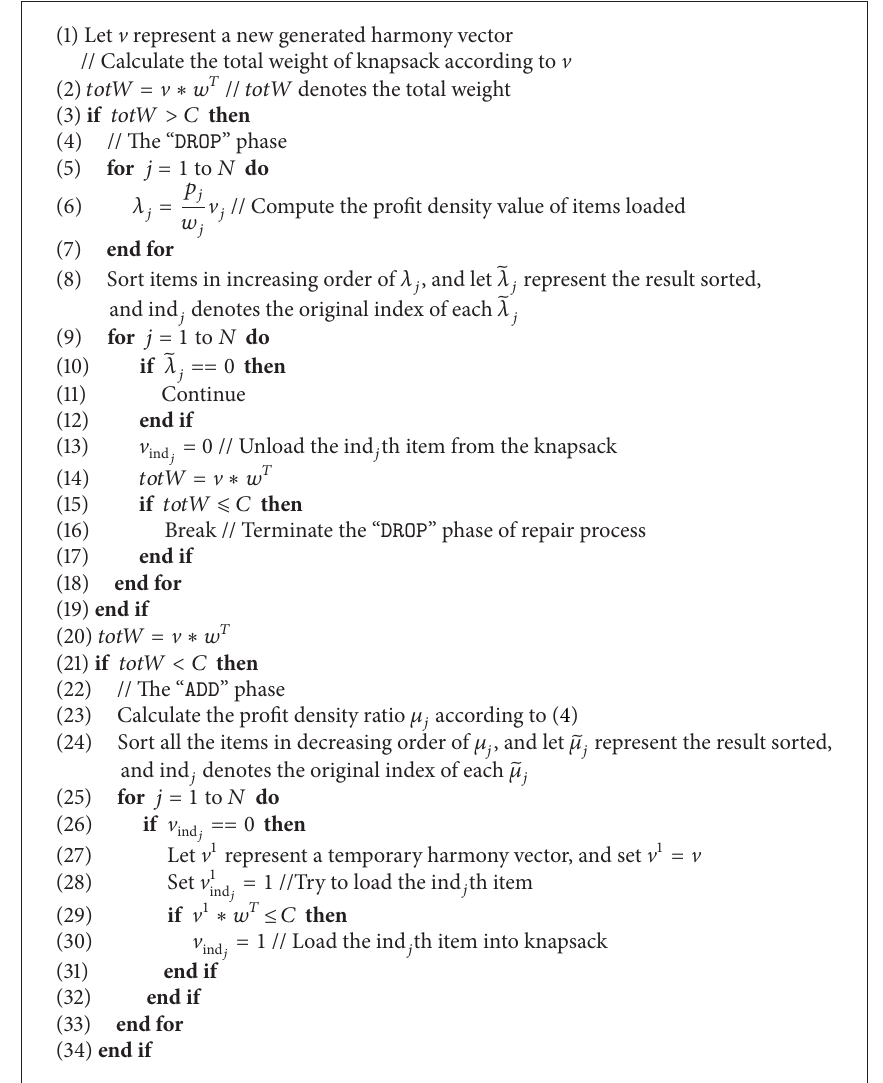
Algorithm 4: The two-phase repair